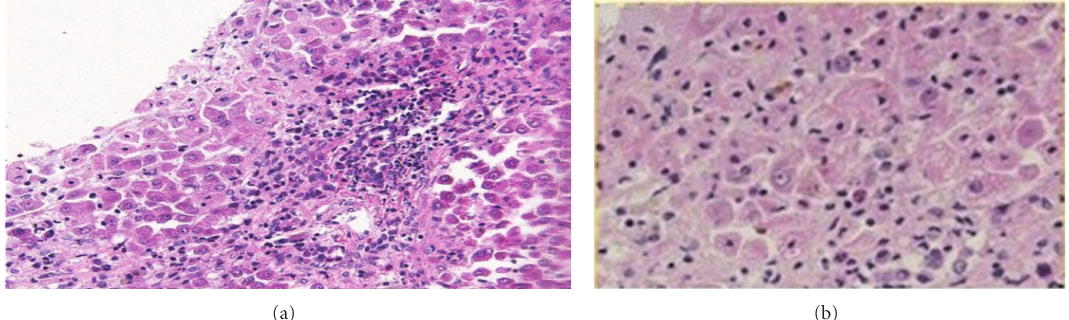
Figure 1: (a) Periportal triad inflammation (b) cholestasis and hepatocyte necrosis (zone 3) iron liver 321 ug/g dry wt (400–2200), hepatic iron index 0.1 umoL/g/yr ( < 1.0).